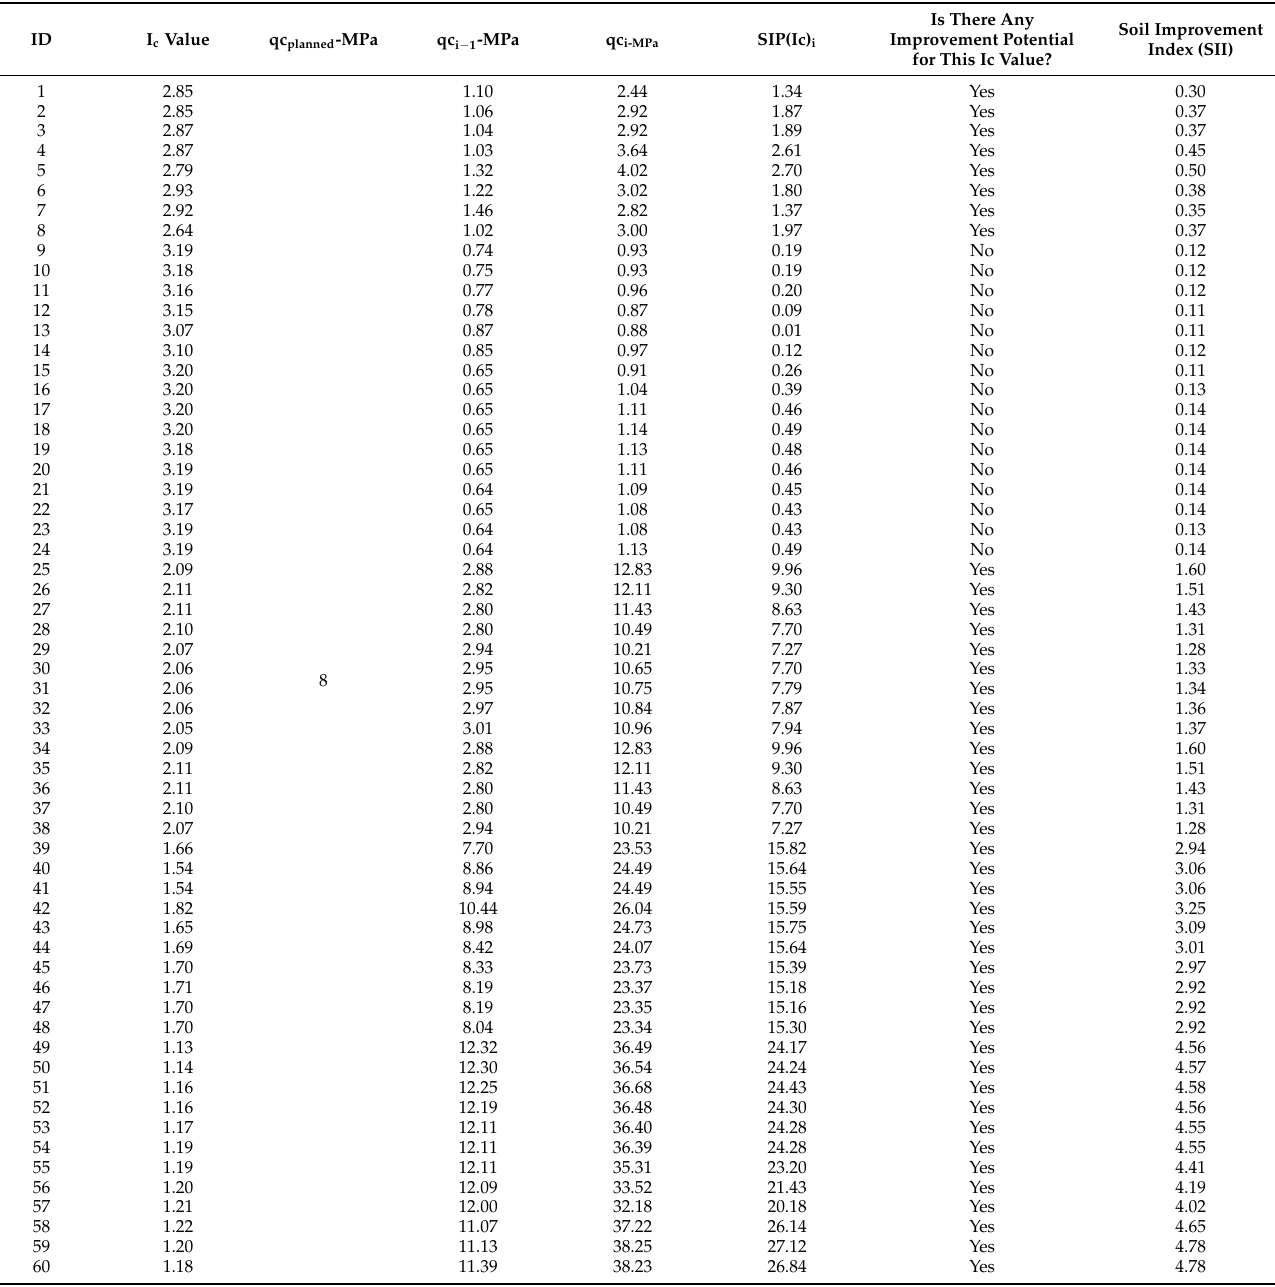
Table 5. Implementation Phase monitoring results of pass i =